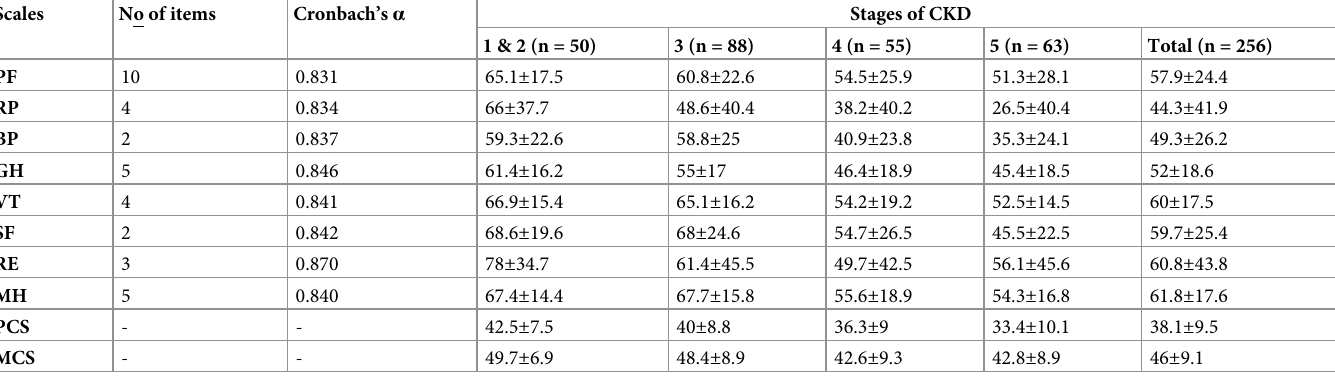
PF = Physical functioning, RP = Physical role functioning, BP = Bodily pain, GH = General health, VT = Vitality, SF = Social functioning, RE = emotional role functioning, MH = Mental health, PCS = Physical summary scores, MCS = Mental summary